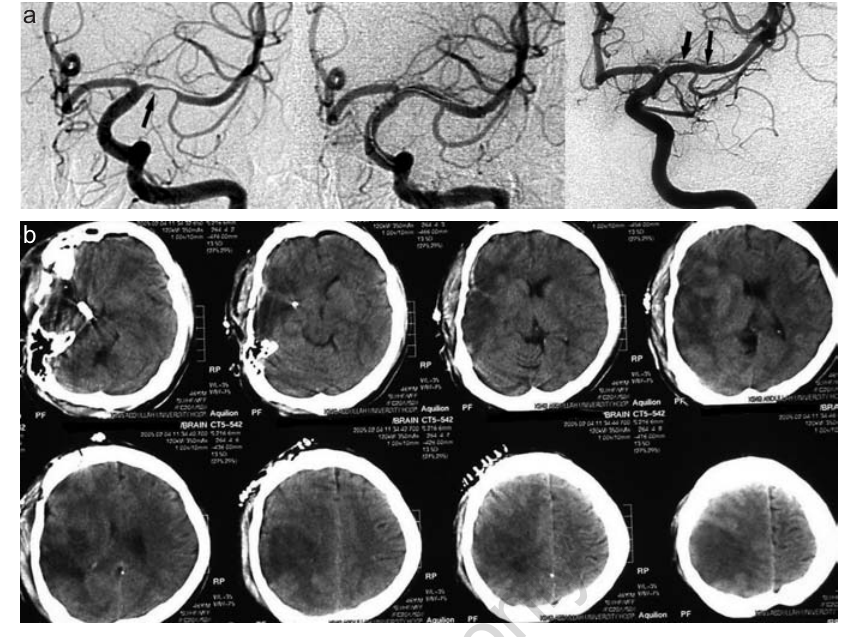
Figure 2. (a) DSA (AP) views pre- and post balloon angioplasty of a young patient suffer- ing severe vasospasm. Narrowing of the anterior cerebral artery can be seen in the pre- bal- loon angioplasty figures (one arrow); the same artery dilated post balloon angioplasty (2 arrows). (b) CT scan of the same patient after recovery from cerebral vasospasm showing R. fronto-parietal ischemic changes. His residual deficits are mild hemiparesis and senso- ry